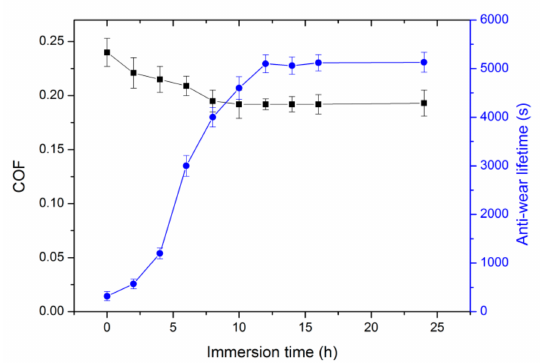
Figure 2. The influence of immersion time of GO on COF and Anti-wear lifetime of GO-APS coating on TNTZ alloy